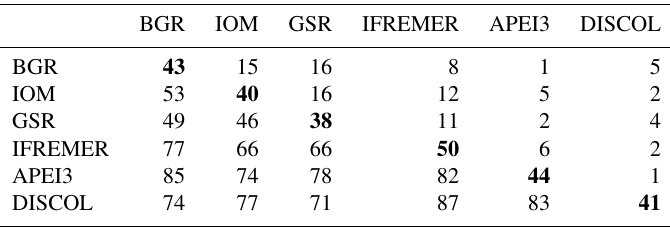
Table 2. Faunistic similarity between areas. The number of shared species is in the upper quadrant, and the number of non-shared species is in the lower quadrant. Total number of species per site (bold in diagonal).